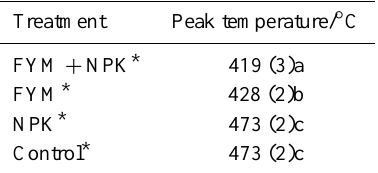
Table 3. FTIR-EGA measured peak temperature of CO 2 evolution during heating from 25 to 700 ◦ C of soils from the Static Fertiliza- tion Experiment, Bad Lauchst¨adt (average years 1956, 1992, 2004). Values in parentheses are standard errors. Different letters within each column indicate a significant difference ( P < 0.05) among the four treatments.